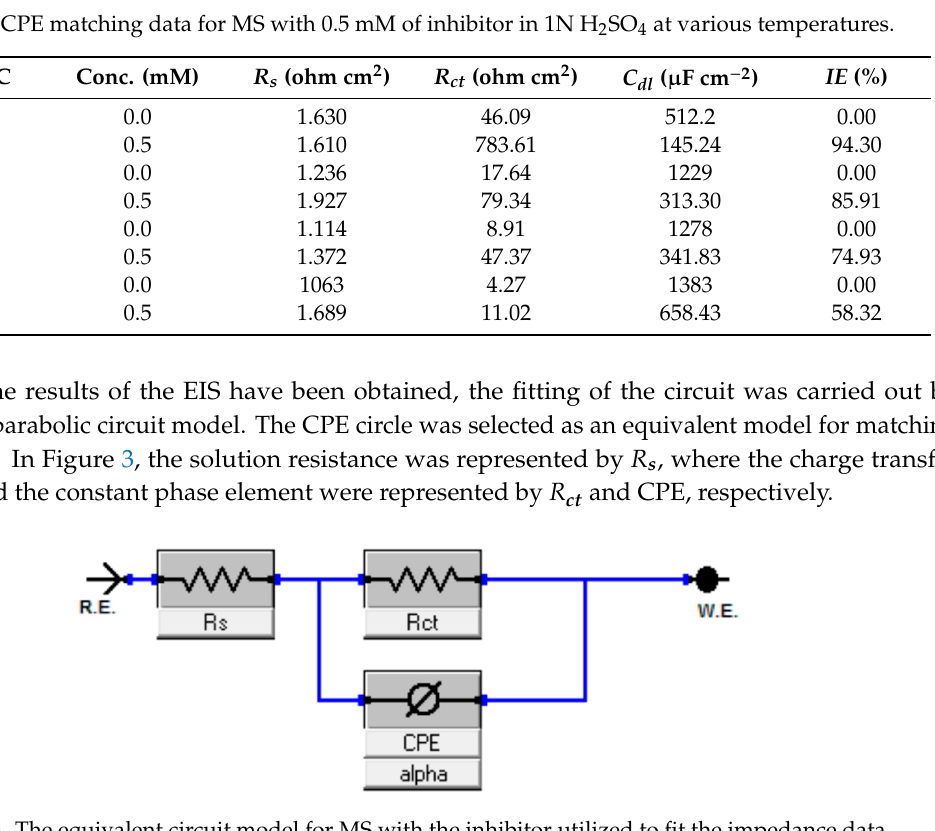
Figure 3. The equivalent circuit model for MS with the inhibitor utilized to fit the impedance data.